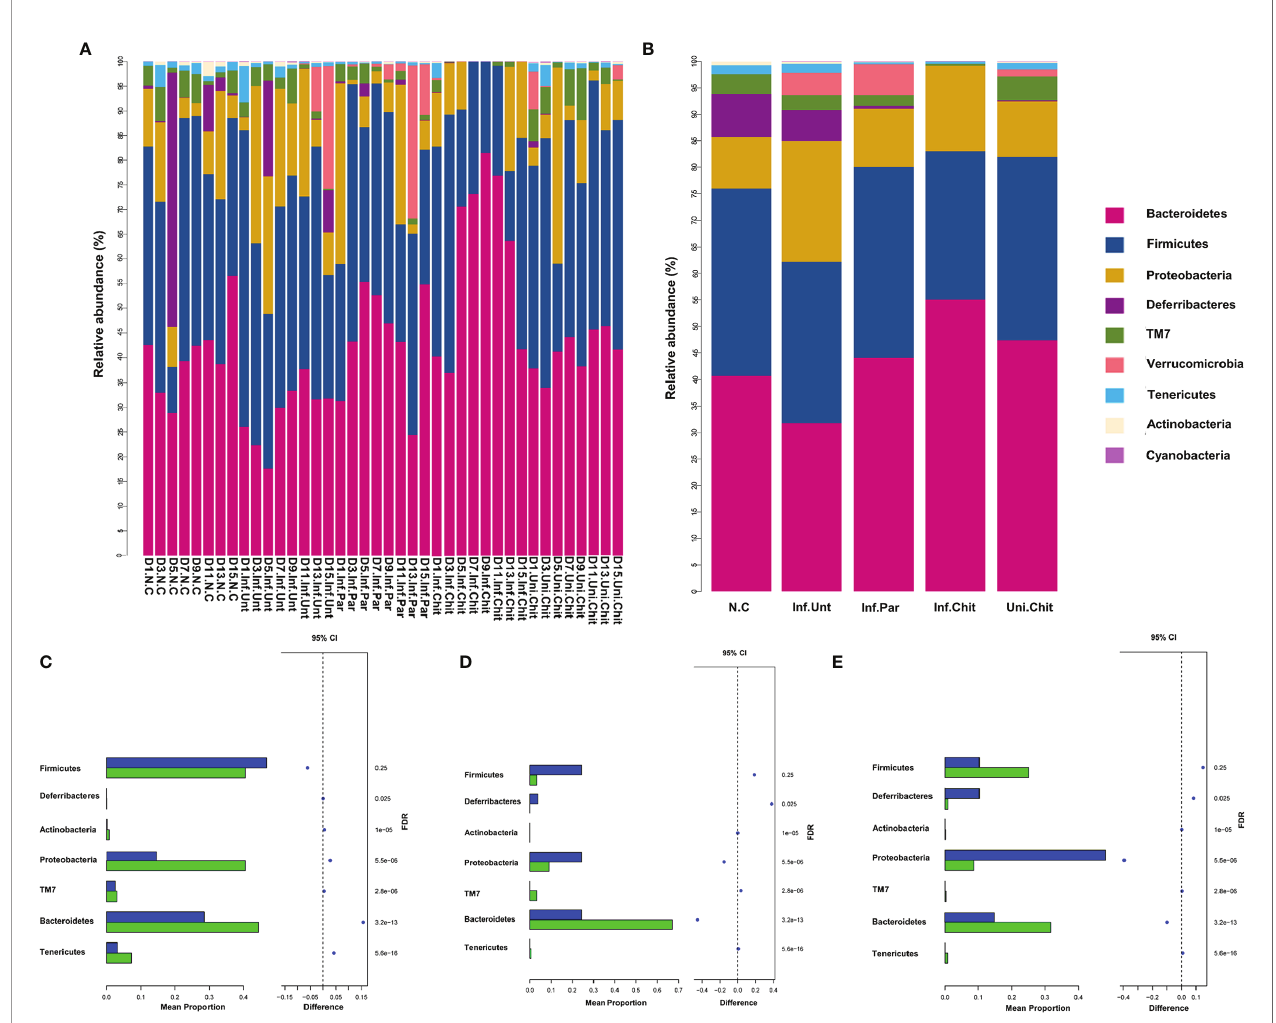
FIGURE 7 | Chitosan supplementation modulated gut microbial community at phylum level in mice infected with C . parvum . (A) Taxonomic distributions of the gut microbiota at phylum level in all samples. (B) Average gut microbial composition of the phylum level in fi ve groups. (C – E) Relative abundance of the gut microbial community between Inf.Unt vs. Inf.Chit groups at phylum level. (C) Day 1, Inf.Unt_Vs Inf.Chit. (D) Day 5, Inf.Unt_Vs Inf.Chit. (E) Day 15, Inf.Unt_Vs Inf.Chit. Blue color indicates Inf.Unt, while green color represents Inf.Chit group. The fi gure shows the difference ratio of functional abundance in 95% con fi dence interval; the right value is the p-value and if p < 0.05, designating signi fi cant